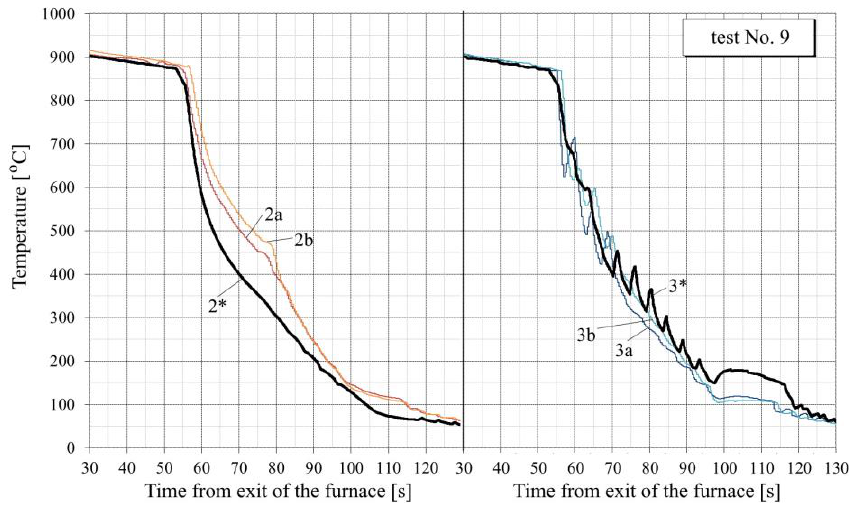
Figure A7. Graphs of cooling in test No. 9. The notations are the same as in Figure A4.